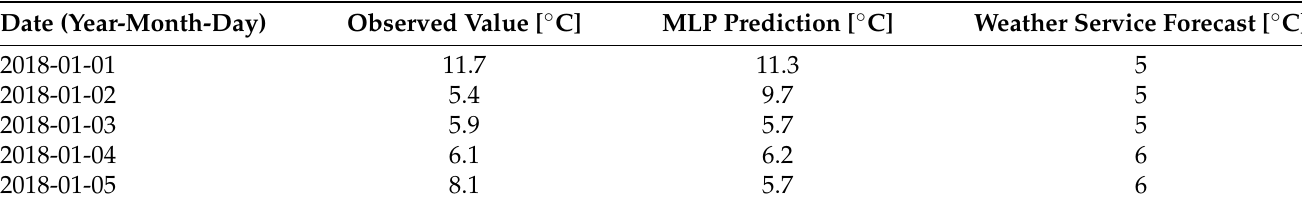
Table A17. Comparison of the MLP prediction and weather service for the maximum